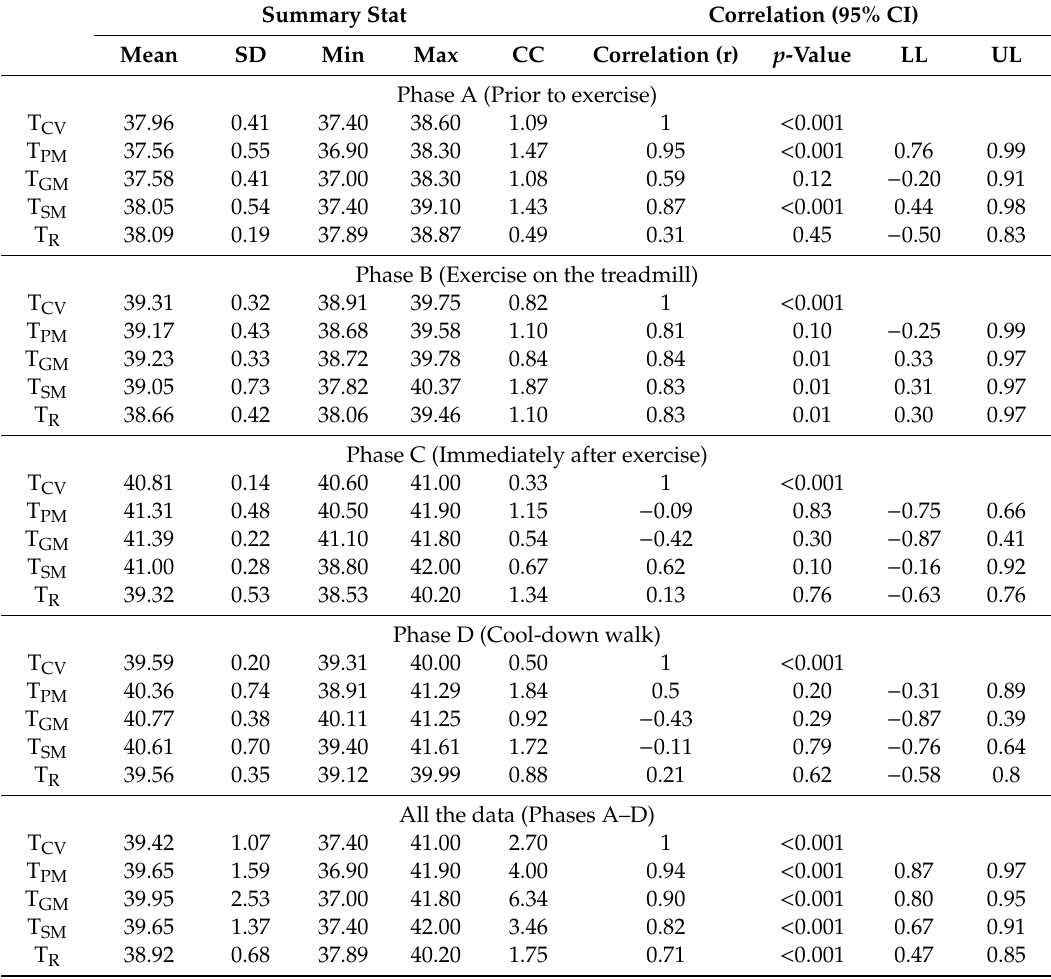
Table 1. Summary of body temperature readings of horses before, during, and after treadmill